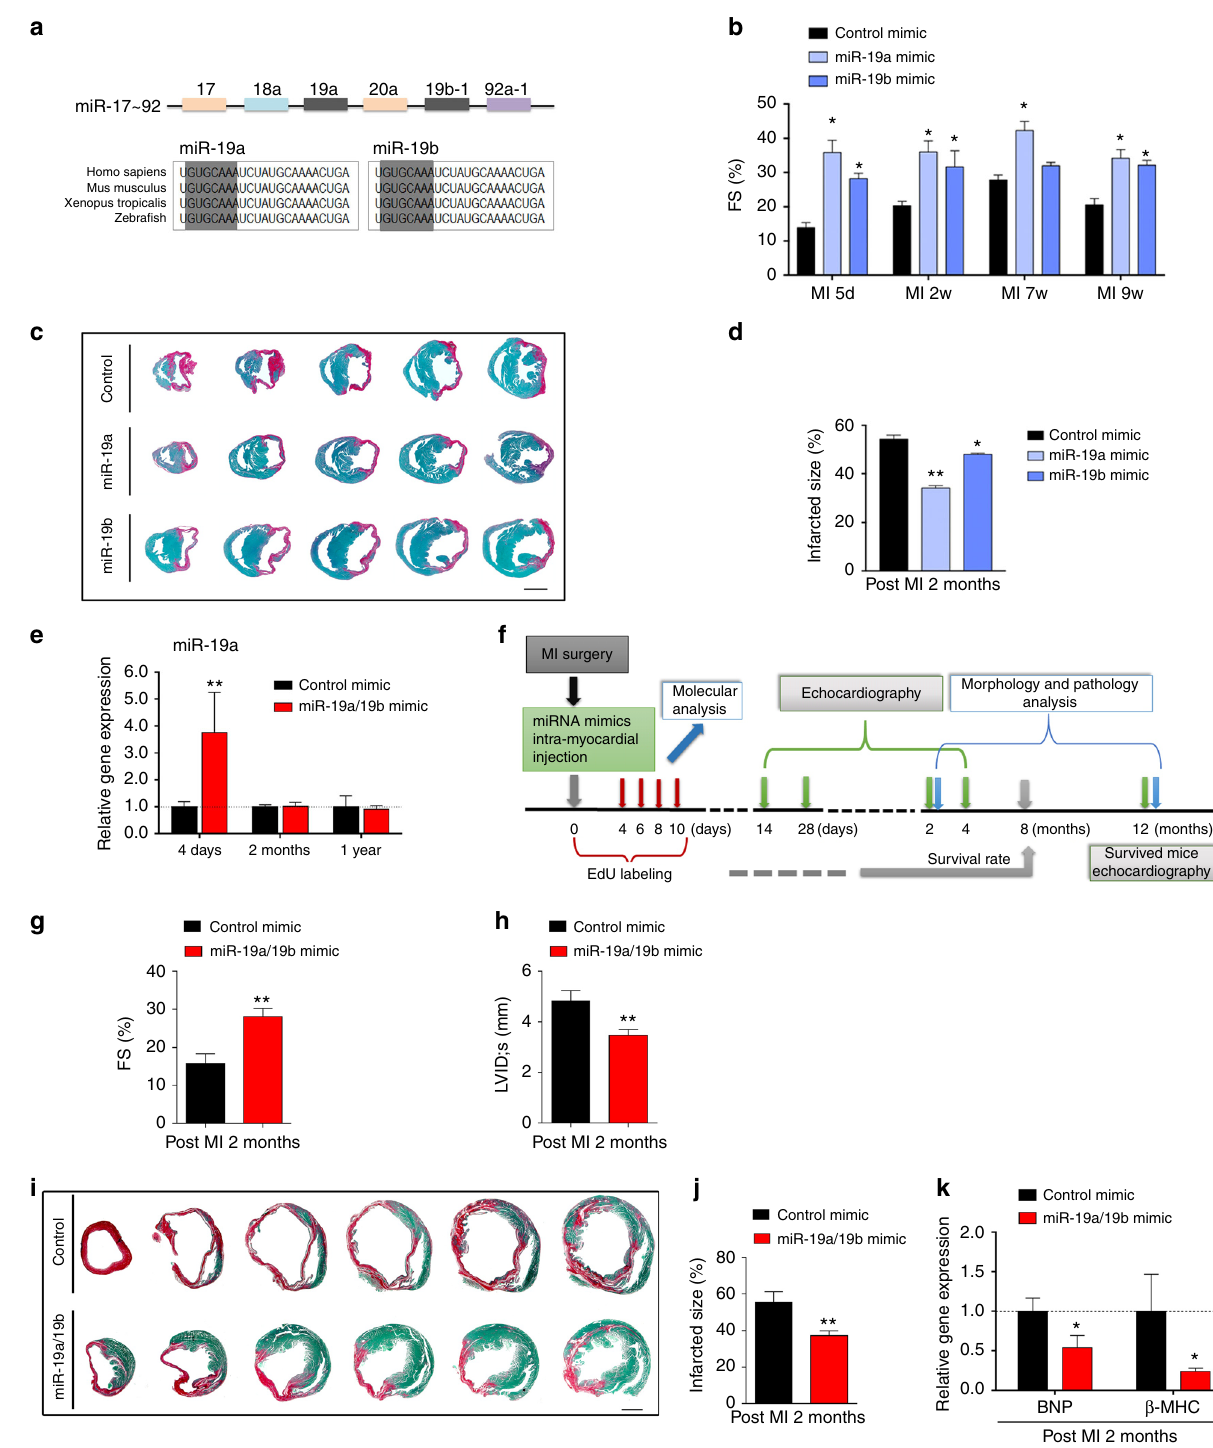
increased miR-19a/19b expression was detected 2 months and 1 overexpression of miR-19a/19b also prevented MI-induced year later in miR-19a/19b mimic-injected hearts (Fig. 2e). We cardiac dilation in these mice (Fig. 2h; Supplementary Table 2). systematically analyzed cardiac phenotypes in these miR-19a/ We performed histological analysis and found that injection of 19b mimic-injected mice (Fig. 2f; Supplementary Table 2). miR-19a/19b mimics signi fi cantly reduced scar formation in Cardiac function was measured using echocardiography, and we infarcted hearts (Fig. 2i). Quanti fi cation of infarct size found that mice injected with miR-19a/19b mimics exhibit con fi rmed this observation (Fig. 2j). We further examined the improved cardiac function, as evidenced by preserved fractional expression of molecular marker genes and found that the shorting (FS%), when compared with control mimic-injected expression of brain natriuretic peptide ( Nppa ) and beta-myosin mice (Fig. 2g; Supplementary Table 2). Interestingly, heavy chain ( β -MHC, encodes by Myh7 ), molecular markers of NATURE COMMUNICATIONS| (2019) 10:1802